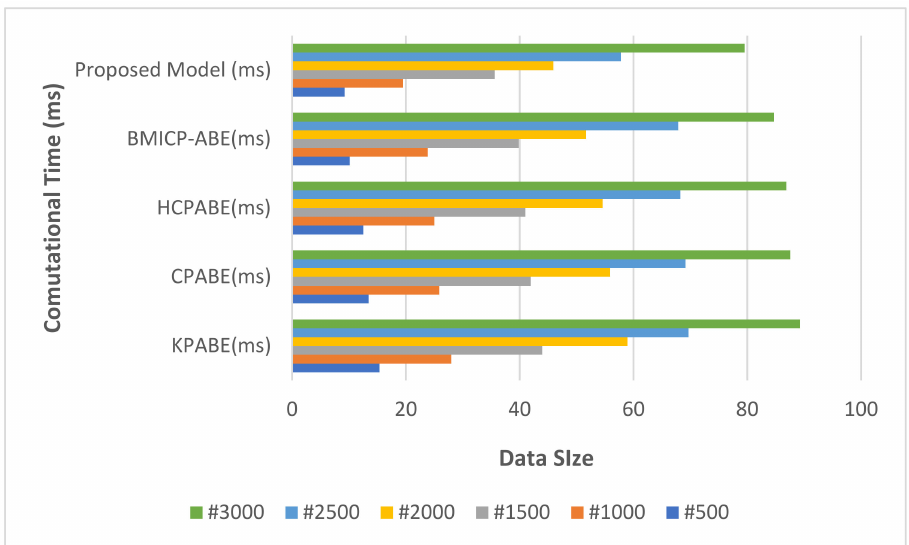
Figure 10. Comparative Analysis of Average Computational Time.